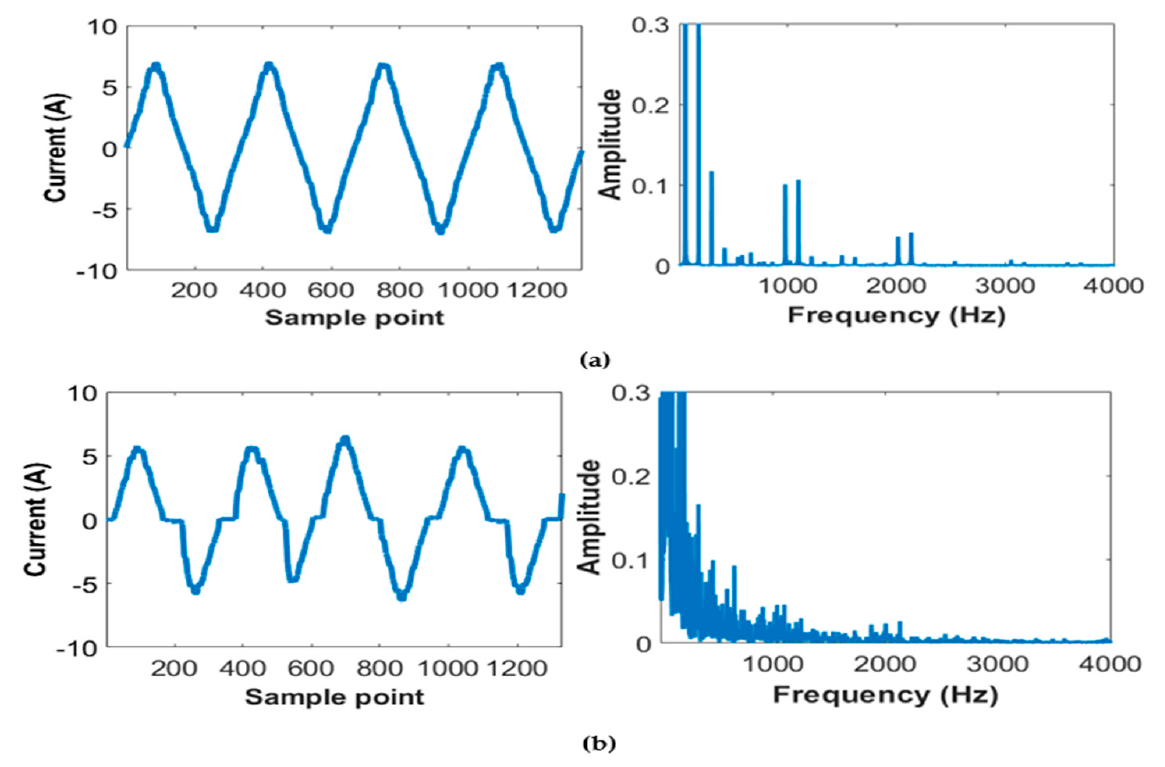
Figure 5. Measurement results for a vacuum cleaner ( a ) normal state, ( b ) arc fault state.